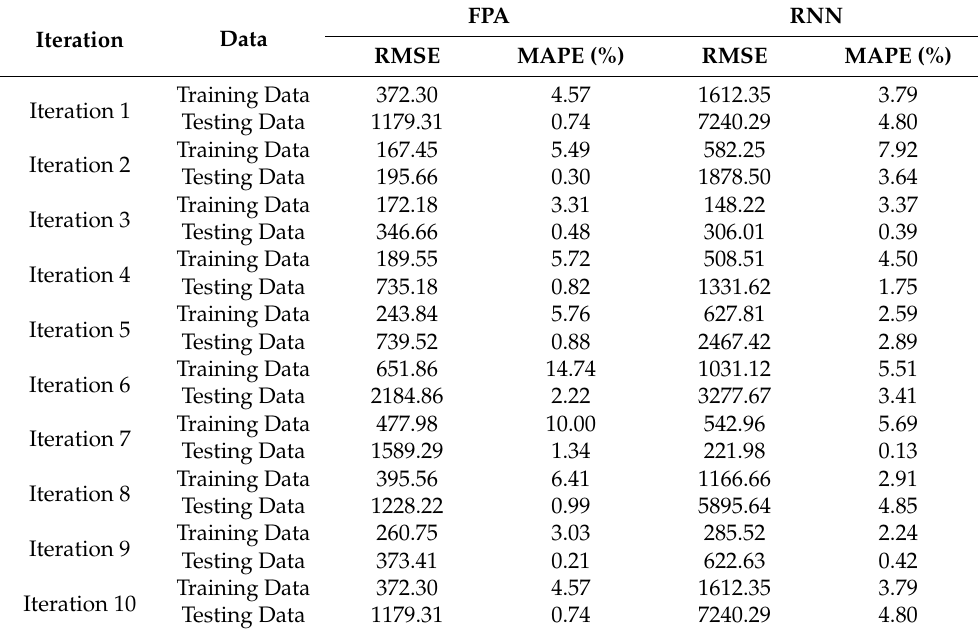
Table 6. Short-term forecasting